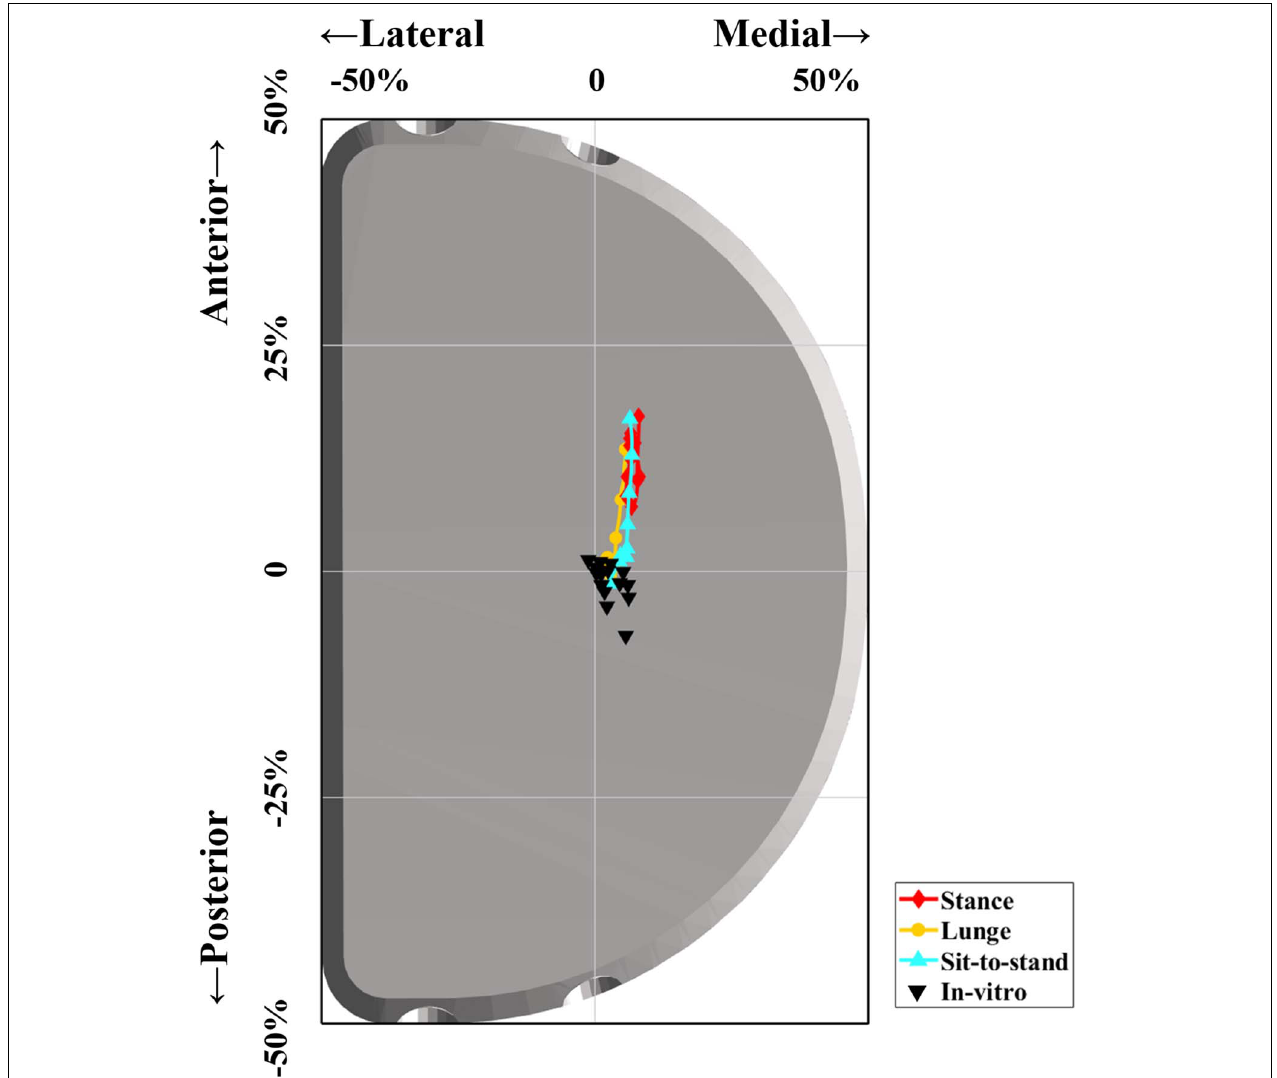
FIGURE 4 | Difference between in vivo contact positions of FB unicompartmental knee arthroplasty (UKA) during functional activities and previous in vitro wear region center. The red, orange, and cyan lines indicate in vivo articular contact excursion during the stance phase, single-leg lunge, and sit-to-stand motion, respectively. The black triangles indicate the center of in vitro wear region or stress distribution area in previous studies (Kwon et al., 2013; Schroeder et al., 2013; Schwiesau et al., 2013b; Koh et al.,